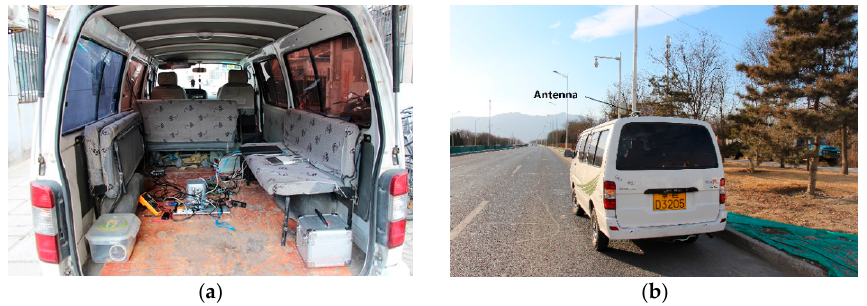
Figure 5. Photographs of the experimental vehicle. ( a ) Inner; ( b ) Exterior.